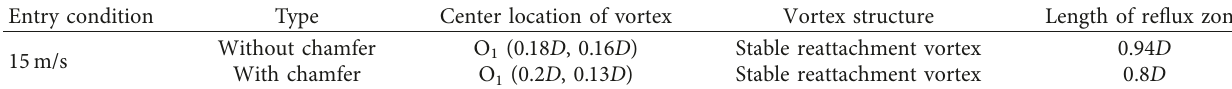
Figure 20: With chamfer (sudden spread ratio is 1.5). Table 5: Sudden spread ratio of 1.5 with or without chamfer reflux zone.